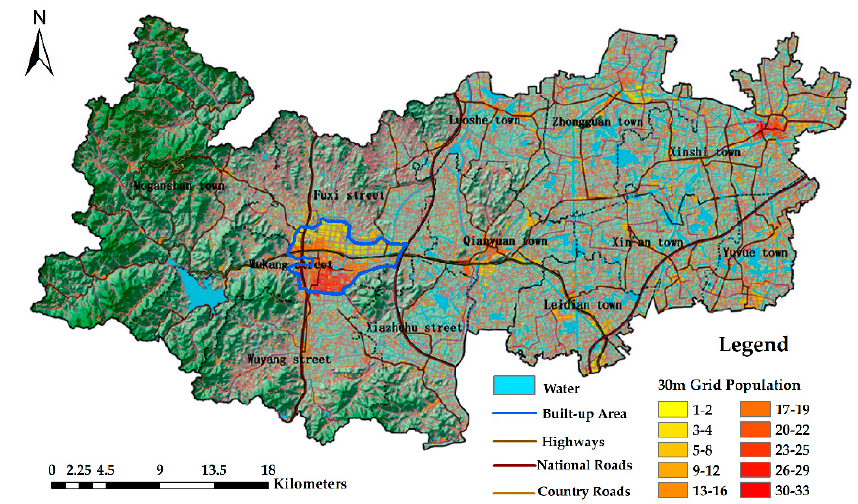
Figure 3. Spatial distribution of population in Deqing County.